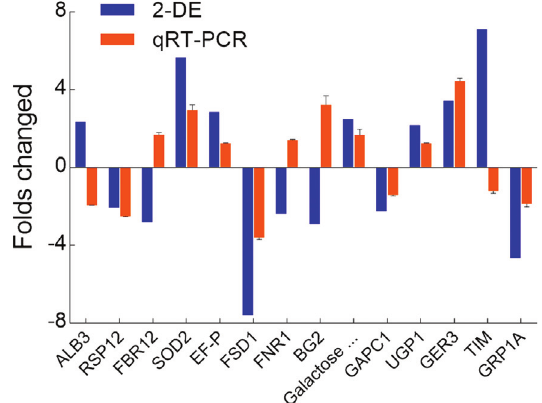
Figure 6 - Comparison of the results obtained from 2-DE with those from qPCR. The results obtained by 2-DE and qPCR are marked in blue and or- ange columns, respectively. The Y-axis represents the fold-change in the Bnclv-like mutant relative to the wild type.